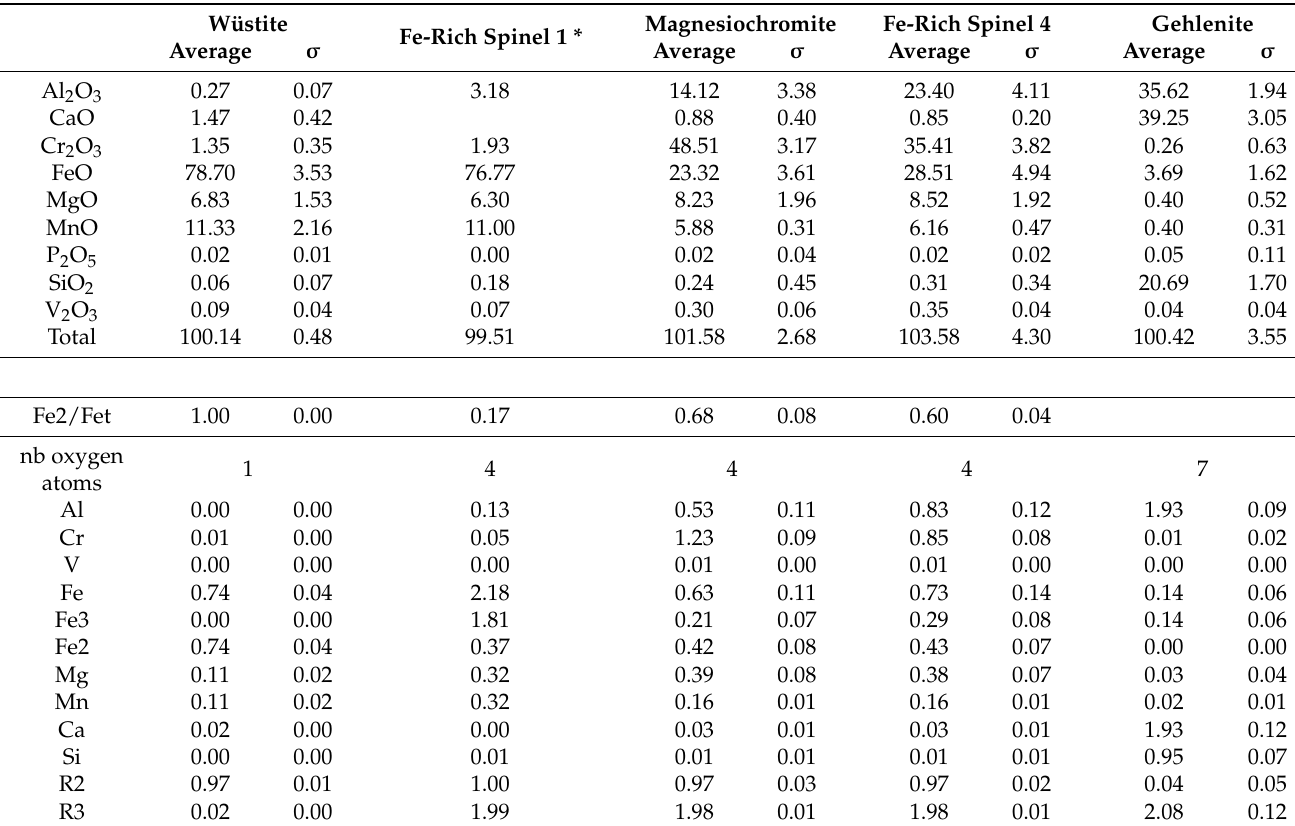
Table 8. Average chemical compositions and standard deviation ( σ ) of minerals identified in the non-magnetic fraction. Compositions were acquired using electron microprobe and expressed in weight percent of oxides. The structural formulae were calculated on the basis of the number of oxygen atoms in the mineral (1 for wüstite, 4 for minerals of the spinel group including magnetite and chromite, and 7 for gehlenite), and expressed in atom per formula unit (apfu). Wüstite Magnesiochromite Fe-Rich Spinel 4 Fe-Rich Spinel 1 *